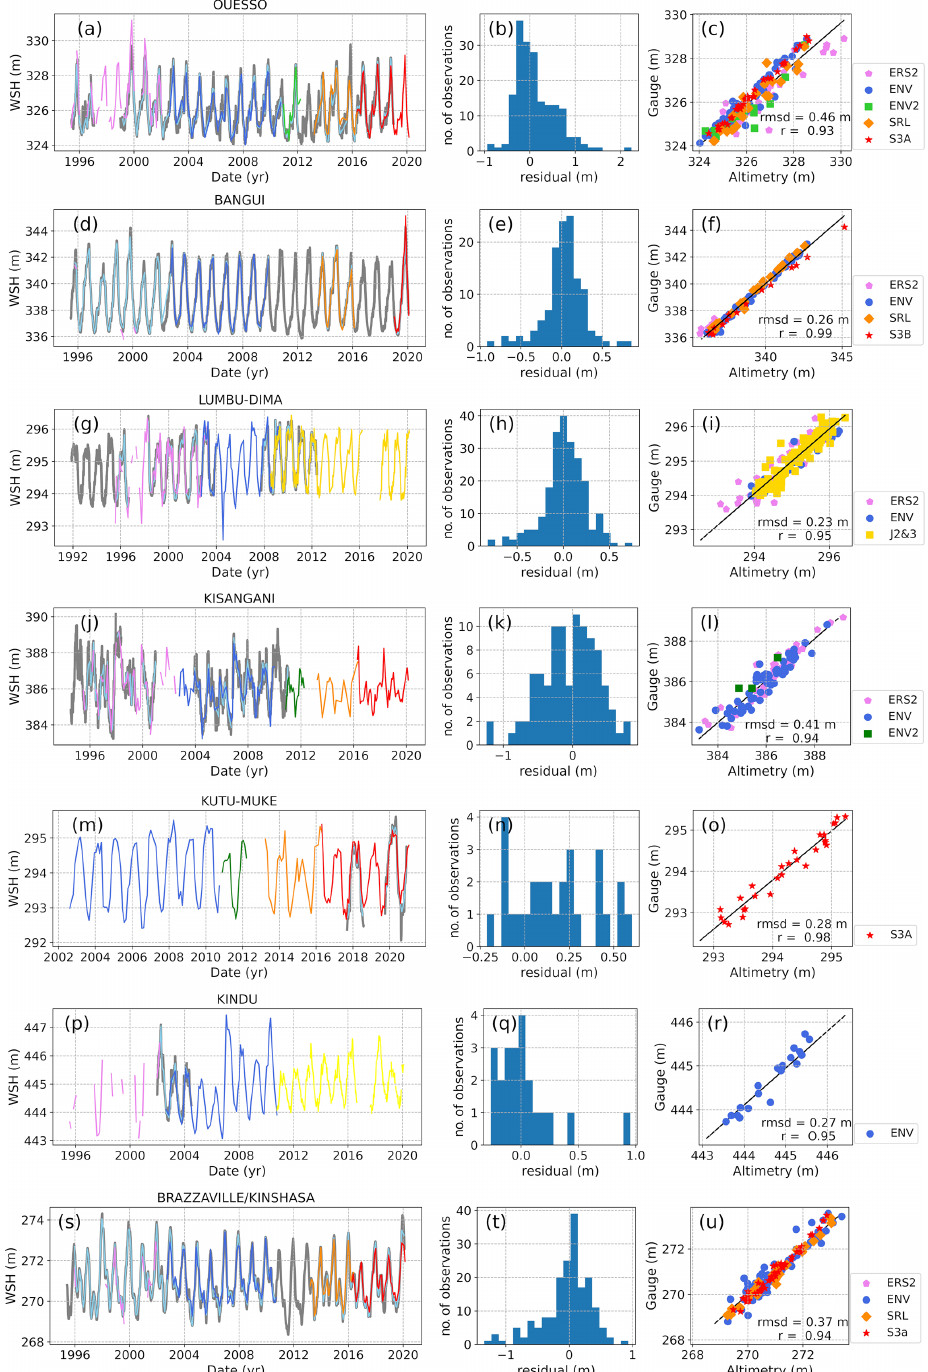
Figure 3. Comparison of the in situ water stage (Table 1) and long-term altimeter-derived SWH obtained by combining ERS-2, ENV, ENV2, SRL, J2/3, and S3A/B at different sites (see Fig. 1 for their locations). (a, d, g, j, m, p, s) The time series of both in situ and altimetry-derived water heights, where the grey line in the background shows the in situ daily WS variations (grey), and the sky blue line indicates the in situ WS sampled at the same date as the altimeter-derived SWH from ERS-2 (purple), ENV (royal blue), ENV2 (lime green), SRL (dark orange), J2/3 (yellow), and S3A/S3B (red) missions. (b, e, h, k, n, q, t) The histogram of the difference between the altimeter-derived SWH and the in situ WS. (c, f, i, l, o, r, u) The scatterplot between altimeter-derived SWH and in situ WS. The linear correlation coefficient r and the root mean square deviation (rmsd), considering all the observations, are indicated. The solid line shows the linear regression between both